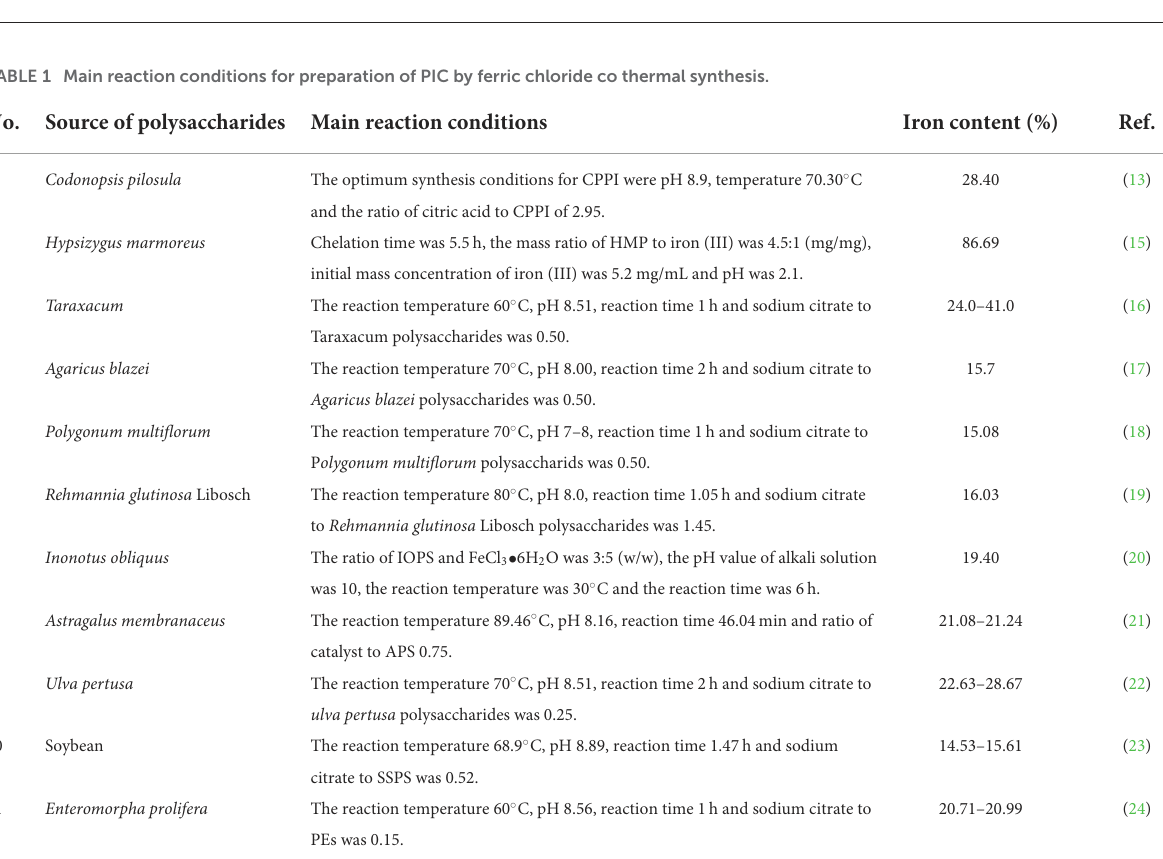
FIGURE2 Preparation of PIC by ferric chloride co thermal synthesis.